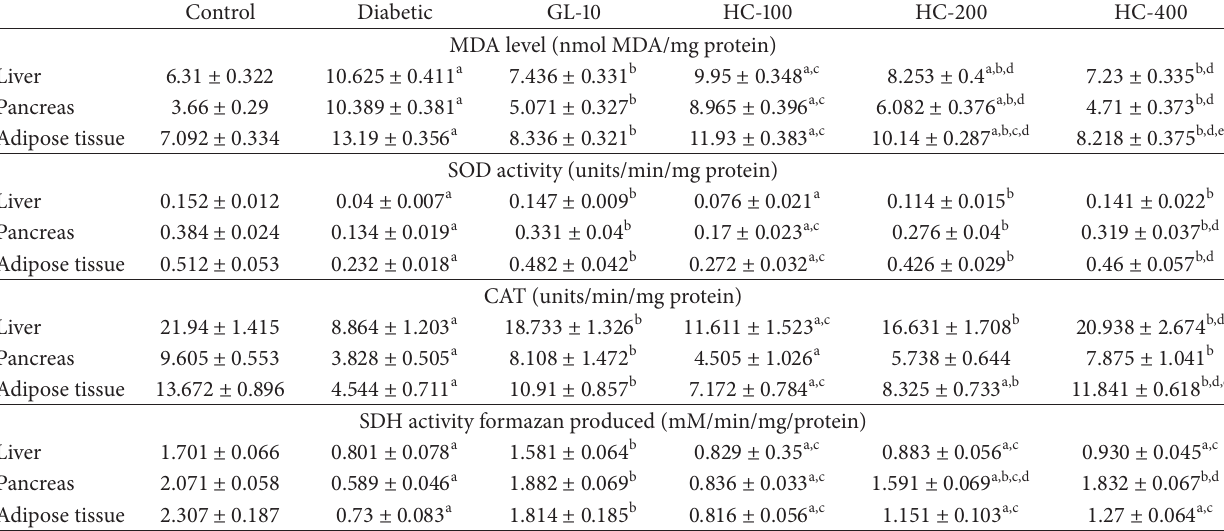
Table 5: Effect of HC on mitochondrial MDA, SOD, CAT, and SDH levels in liver, pancreas, and adipose tissue of diabetic